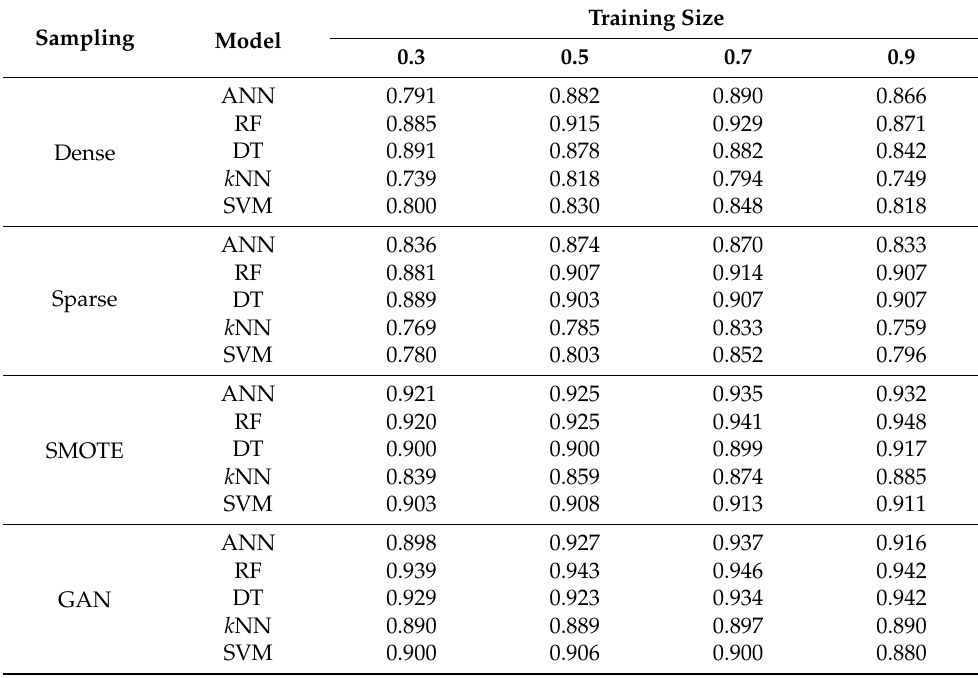
Table A8. Assessment of the models with different sampling methods based on AUROC.